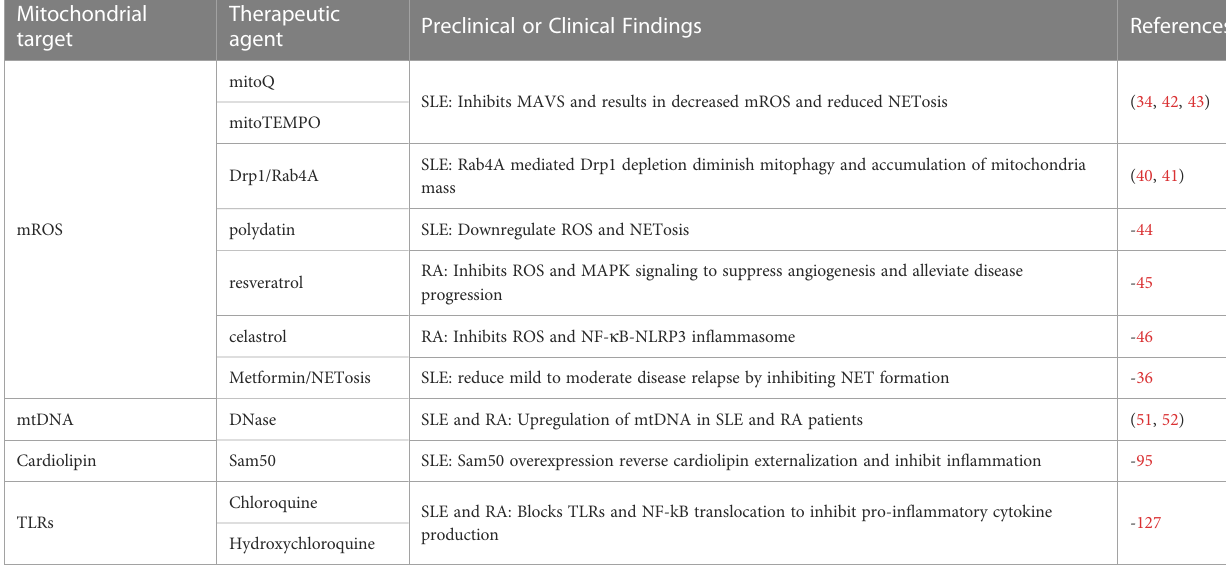
TABLE 1 Potential therapeutic agents targeting mitochondrial molecules in SLE and